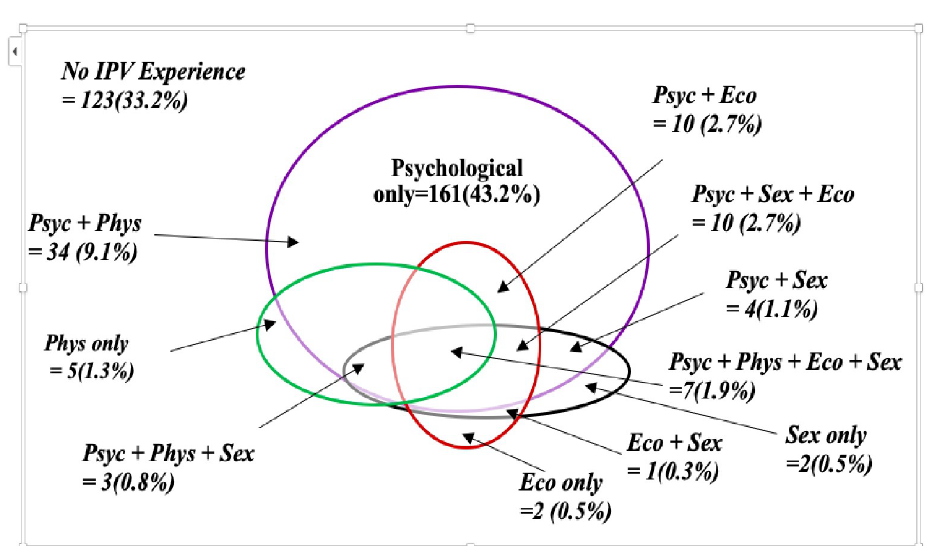
Fig 1. The overlapping forms of IPV perpetrated against pregnant women in the rural Gambia. Note: N = 373; Psyc = psychological; Phys = physical; Eco = economic; sex = sexual.